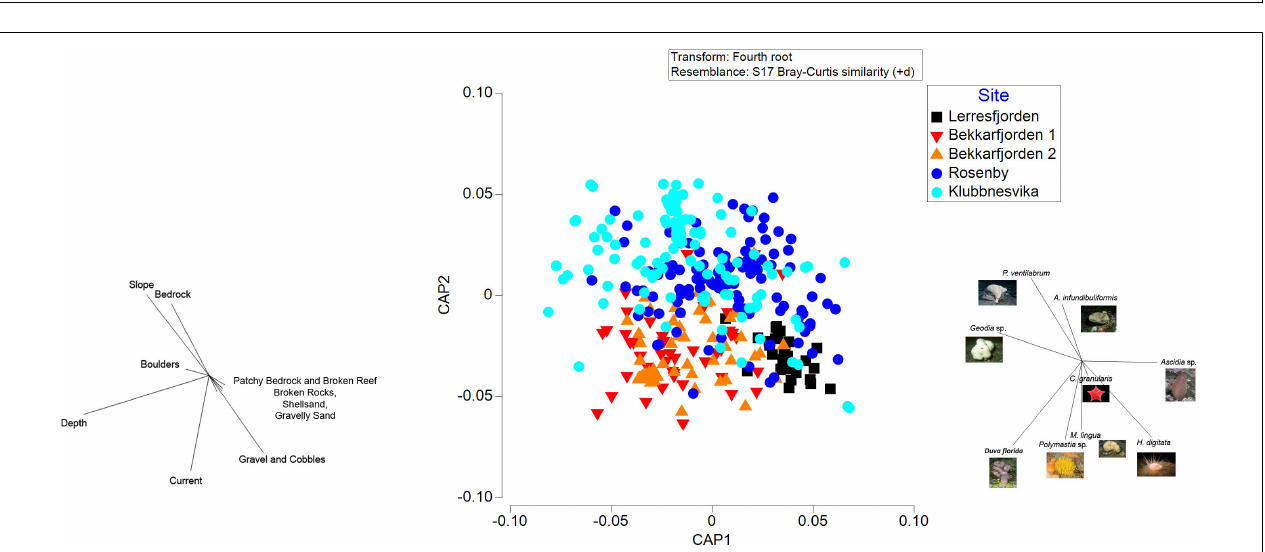
FIGURE 8 | Canonical analysis of principal coordinates, based on Bray-Curtis dissimilarity, of the composition of epifaunal taxa at the survey sites (Lerresfjorden, Bekkarfjorden 1 and 2, Rosenby, and Klubbnesvika). Vectors overlays to the left represent the Spearman rank correlations between epifaunal community structure and substrate and other environmental characteristics. The vector overlay to the right shows the 9 epifauna taxa with the highest Spearman rank correlations with the canonical axes.